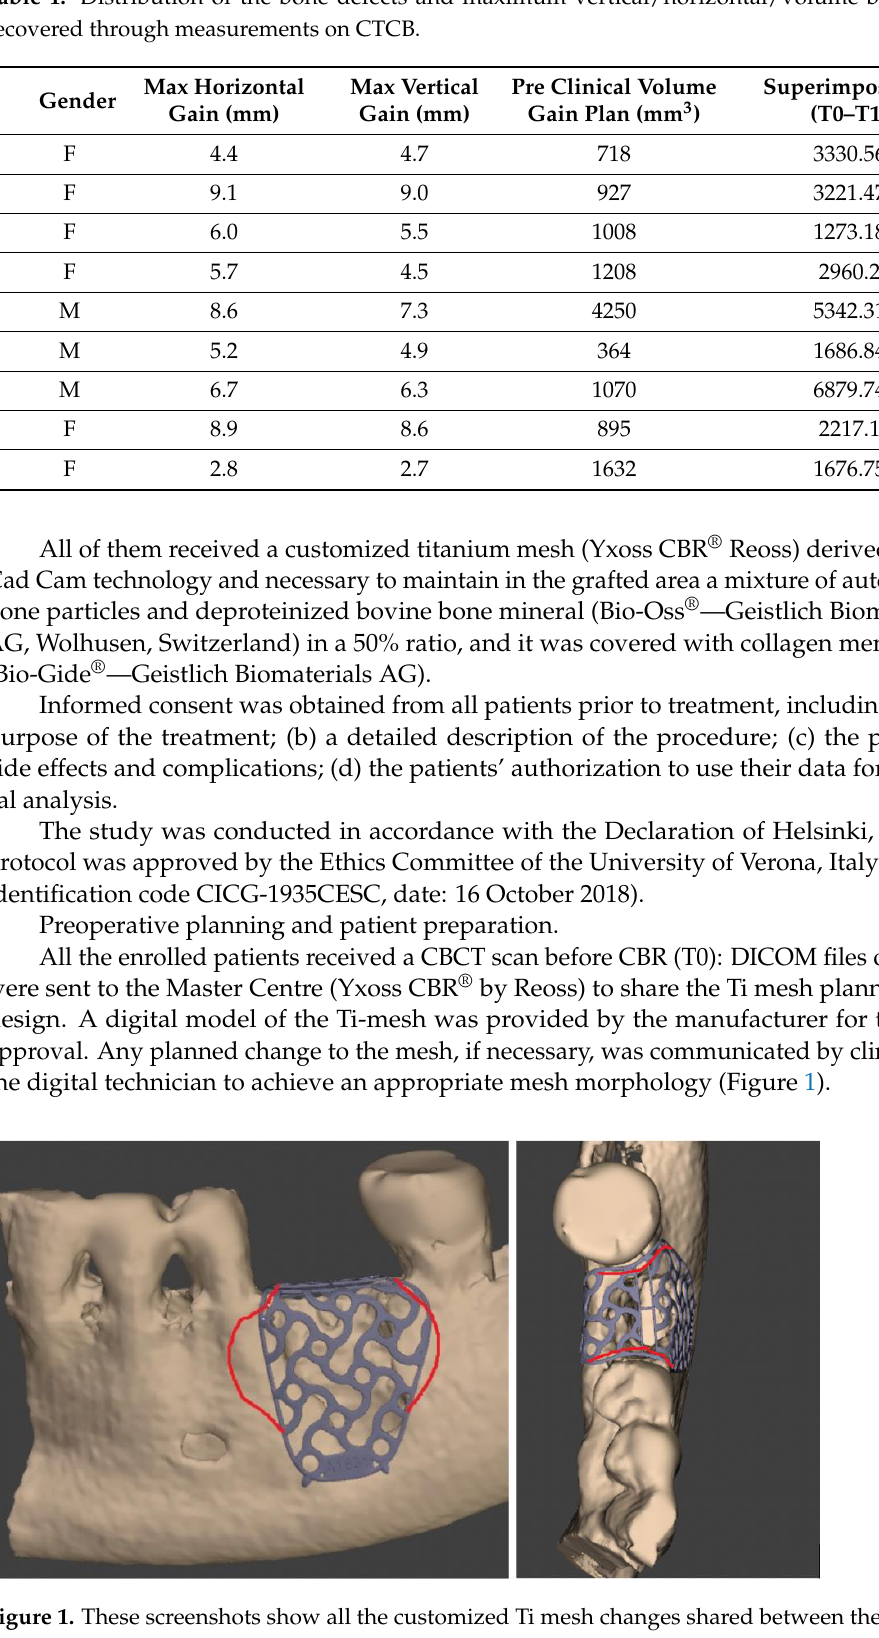
Table 1. Distribution of the bone defects and maximum vertical/horizontal/volume bone gain recovered through measurements on CTCB.